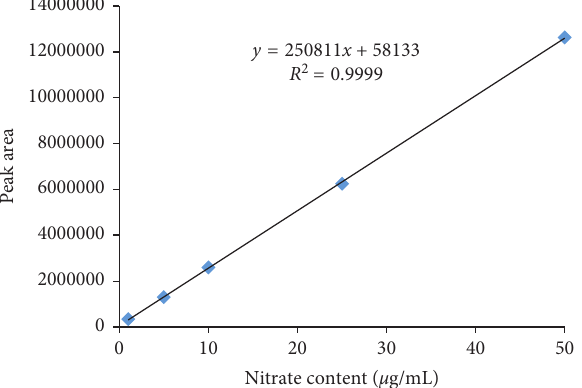
Figure 2: Calibration curve of nitrate for analysis of the nitrate content in C. anisata leaves.